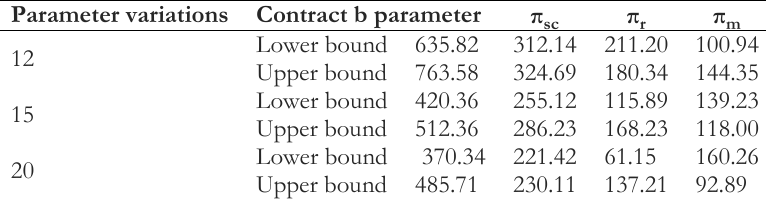
According to the analysis of Table 13 , with increase in the input parameter β , the profit of the whole chain decreased . Nevertheless, the profit of members increased compared to the decentralized scenario . Fig. 11 also shows the trend of variations in firms' profits due to variations in parameter β post-contract for sample problem 1 .